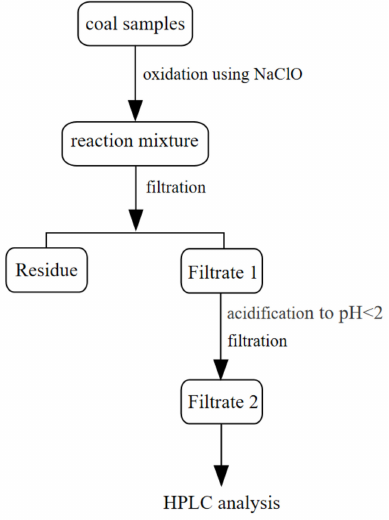
Figure 2. Samples oxidation with